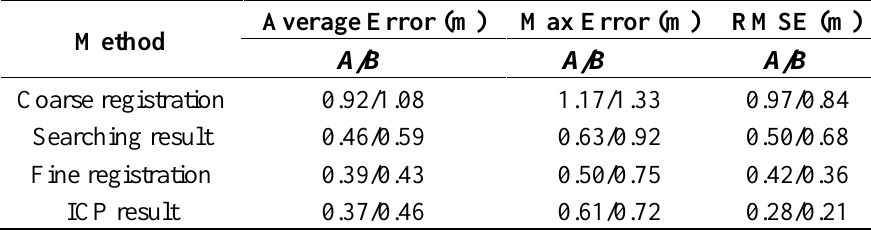
Table 3. Vertical accuracy of the registration